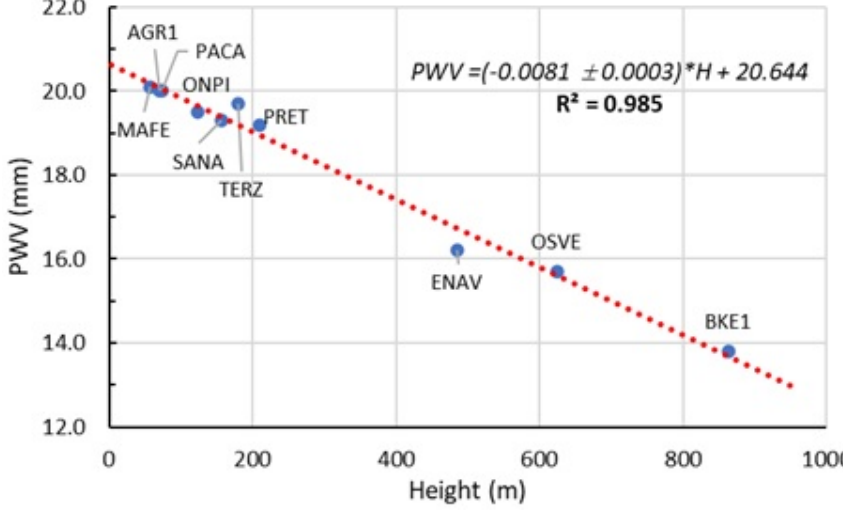
Figure 5. Regression of the average PWV for each station versus its altitude above sea level. For a better visualization of the variability of PWV over the year, a so-called violin plot is used (Figure 6). This representation, which consists of a combination of a classic box plot with a rotated KDE (kerneldensity estimation) on each side, is better suited to dealing with multimodal data and can therefore be used as a simple outlier-detection technique. The PWV mean annual cycle for all the NeVoCGPS stations is shown in Figure 6b. For the PWV mean values, December–February represent the lowest values for all stations and are generally less variable (Figure 6a,b). The highest values are reached during July and August. The increasing trend in PWV mean values from winter to summer is steeper than the decreasing ones from summer to winter. This type of analysis also shows no significant differences between the different stations in the network, with the exceptions of the topographical effect and altitude dependence (Figure 6c). This would suggest almost homogeneous climatic conditions in the analysed sectors of the GPS